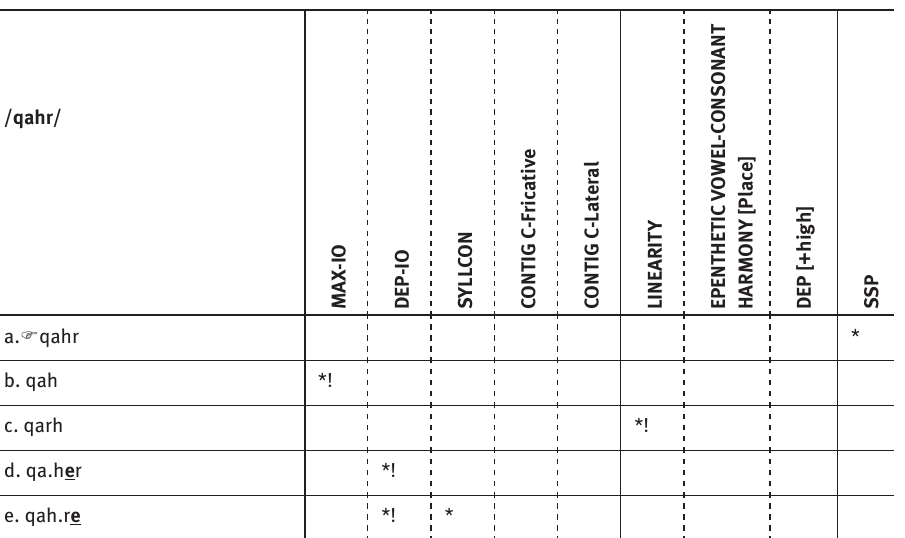
Table 14: MAX-IO, DEP-IO, SYLLCON, CONTIG C-Fricative, CONTIG C-Lateral >>LINEARITY, EPENTHETIC VOWEL-CONSONANT HARMONY [Place], DEP [+high] >>SSP